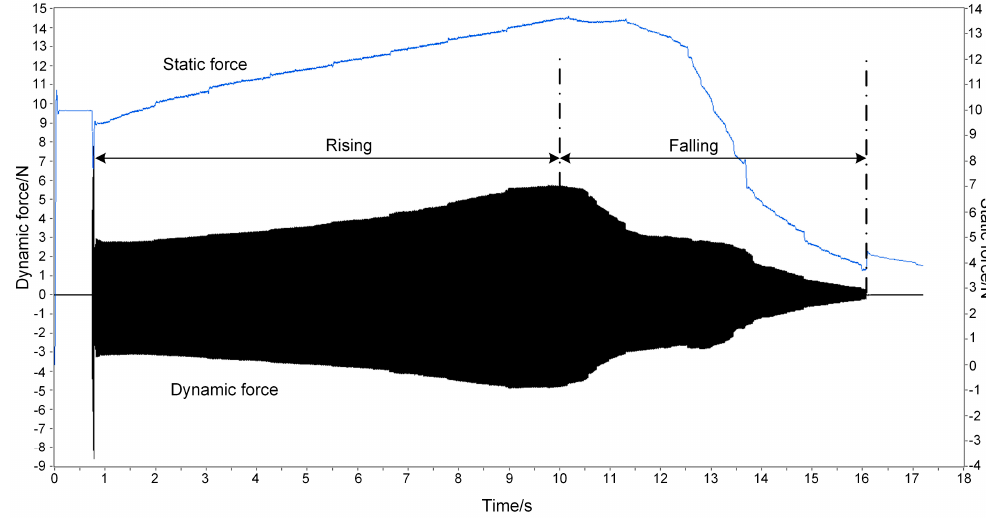
Figure 8. Typical dynamic force and static force in ultrasonic bonding process.